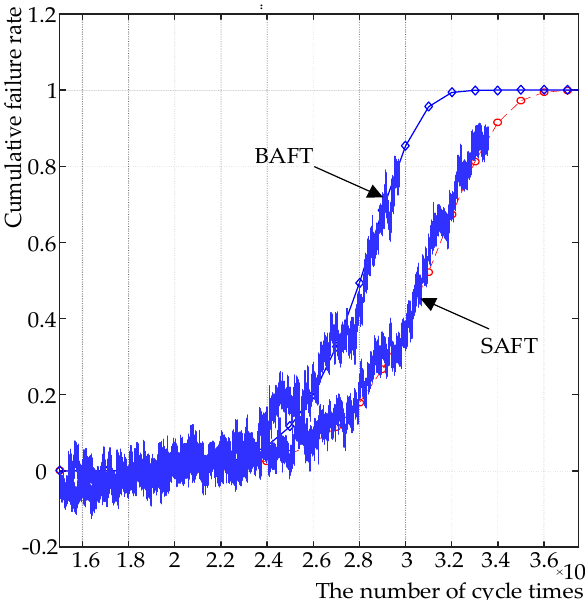
Figure 9. BAFT (bidirectional AFT) and SAFT curves obtained under 1500 A.